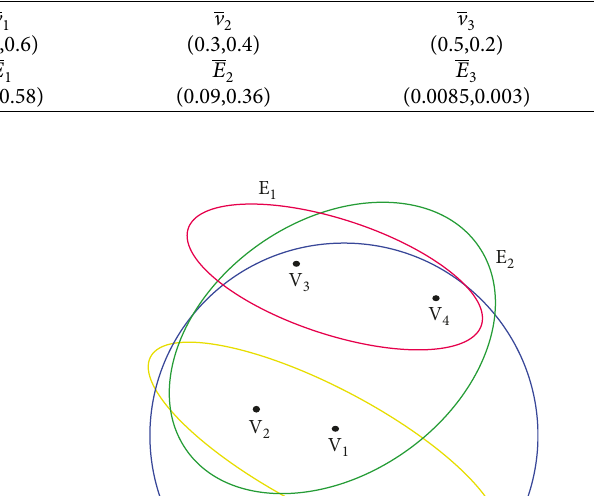
Table 7: Degree of membership and nonmembership values for vertices and edges of Figure